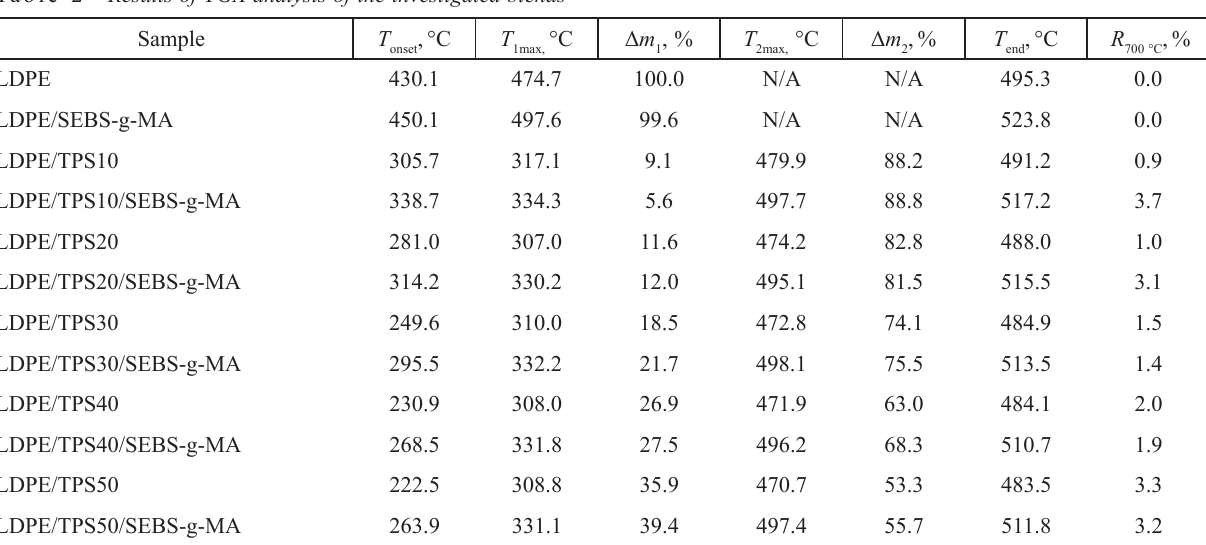
Table 2 – Results of TGA analysis of the investigated blends